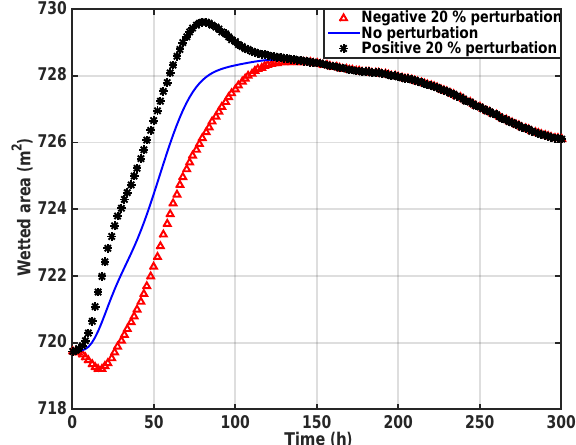
Figure 6. Spin-up for the San Antonio and Guadalupe river network with the SPRNT unsteady SVE model initialized using the SSM approach. The positive and negative 20% perturbations are for the Q initial conditions in first-order